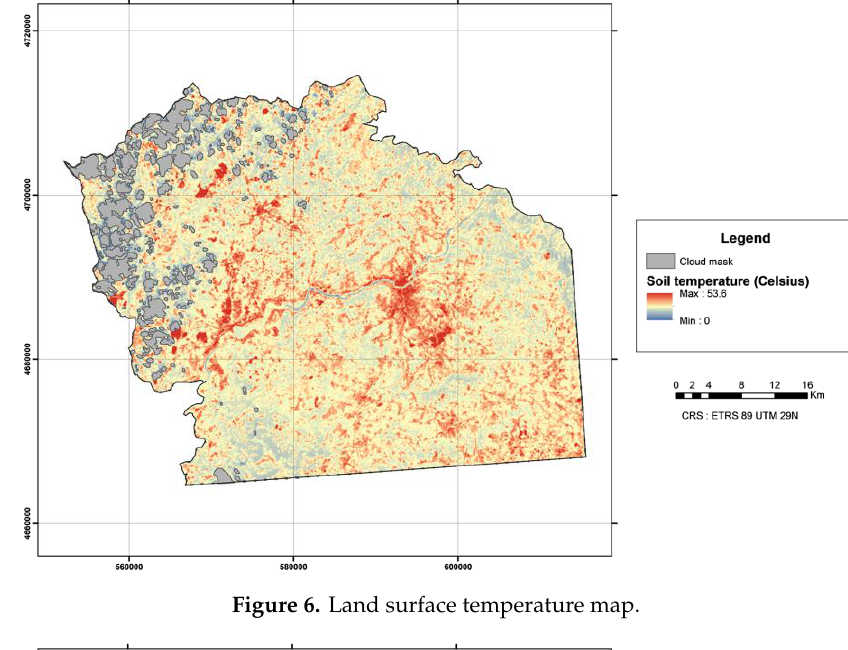
Figure 6. Land surface temperature map.